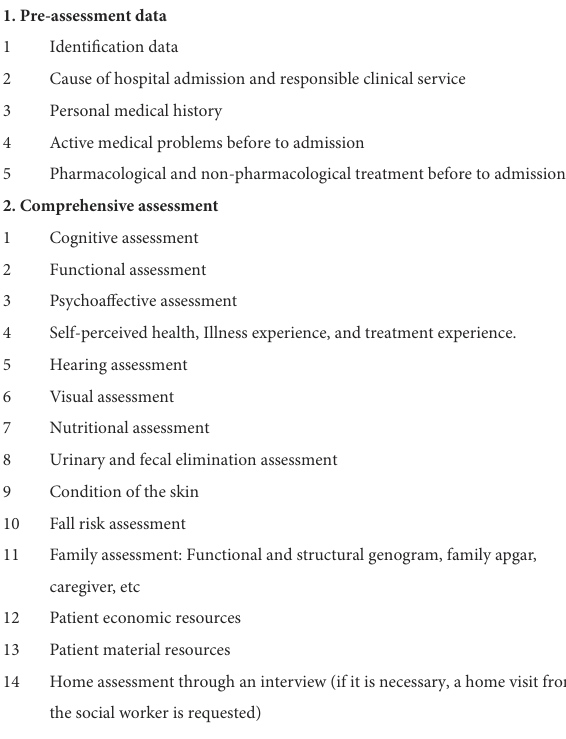
TABLE 2 SPICA program comprehensive assessment